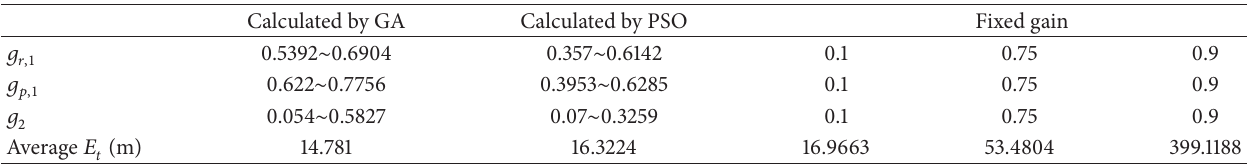
Table 4: Estimation errors for different gains.